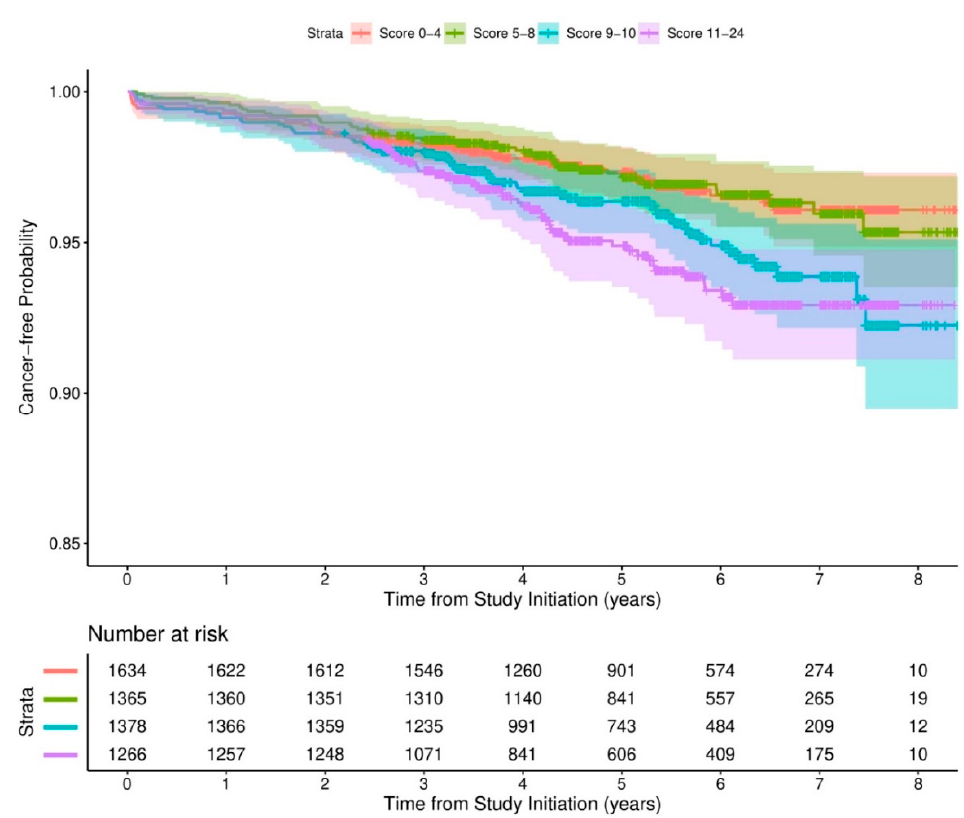
Figure A2. Kaplan–Meier estimates of cancer-free probability by comorbidity risk scores after removing total cholesterol from comorbidity risk score.